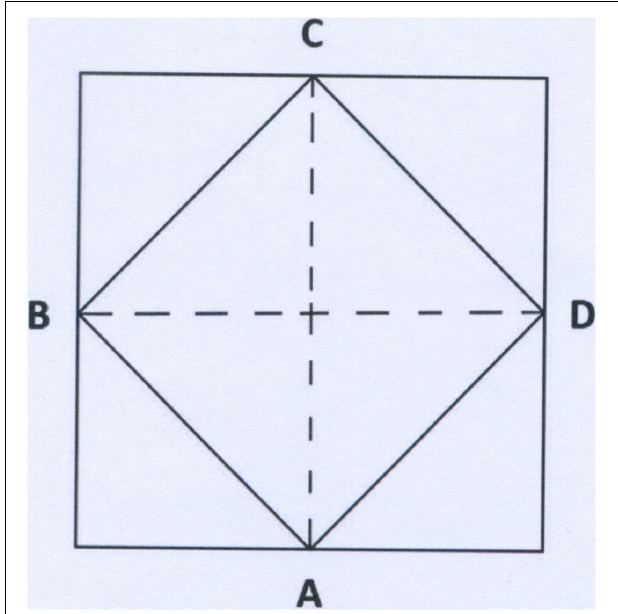
FIGURE 1 | The study window problem